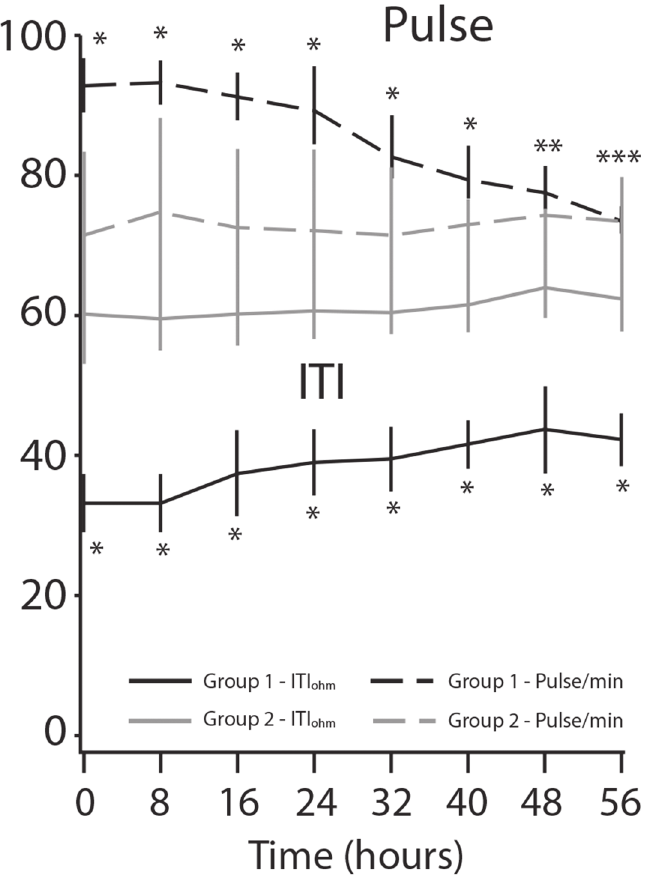
Fig 5. Pulse rate and internal thoracic impedance (ITI) changes over time. * P -value < 0.0001. ** P - value < 0.01. *** P -value = non-significant.